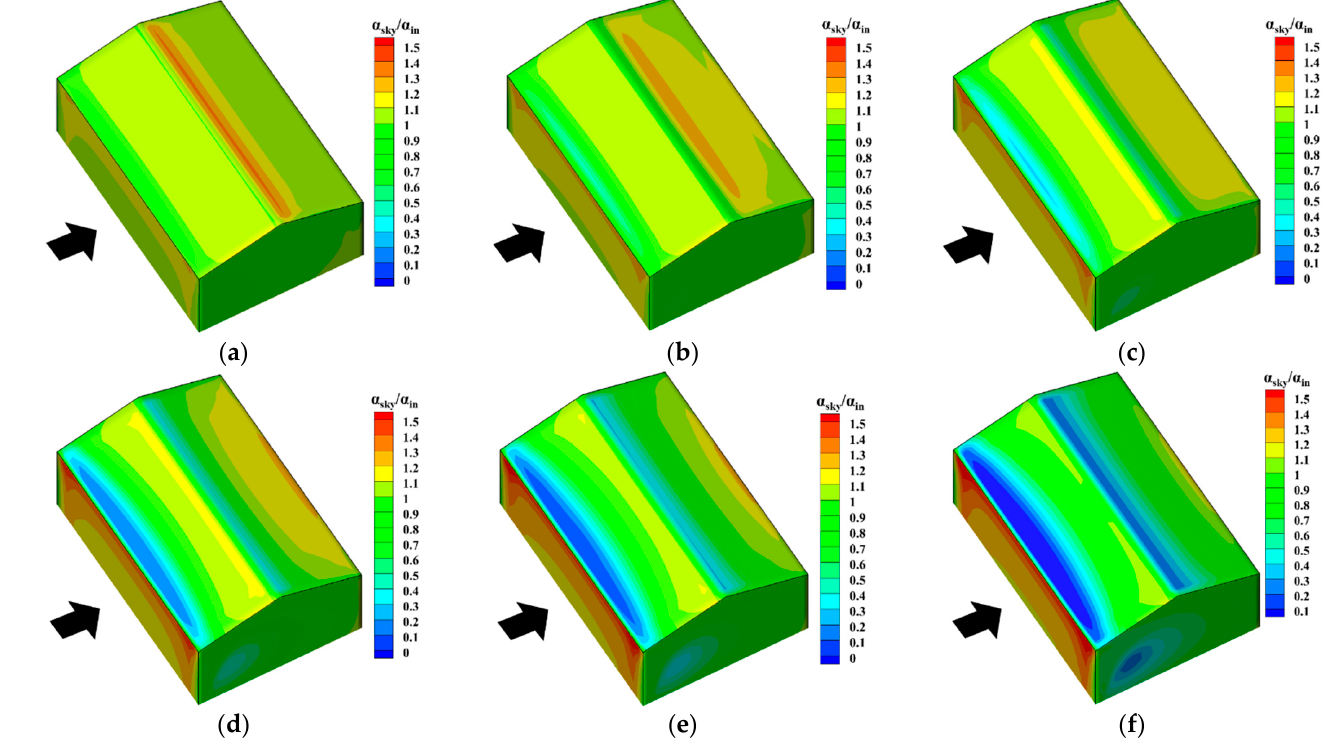
Figure 12. Normalized volume fraction of falling snow α sky / α in around the gable-roofed